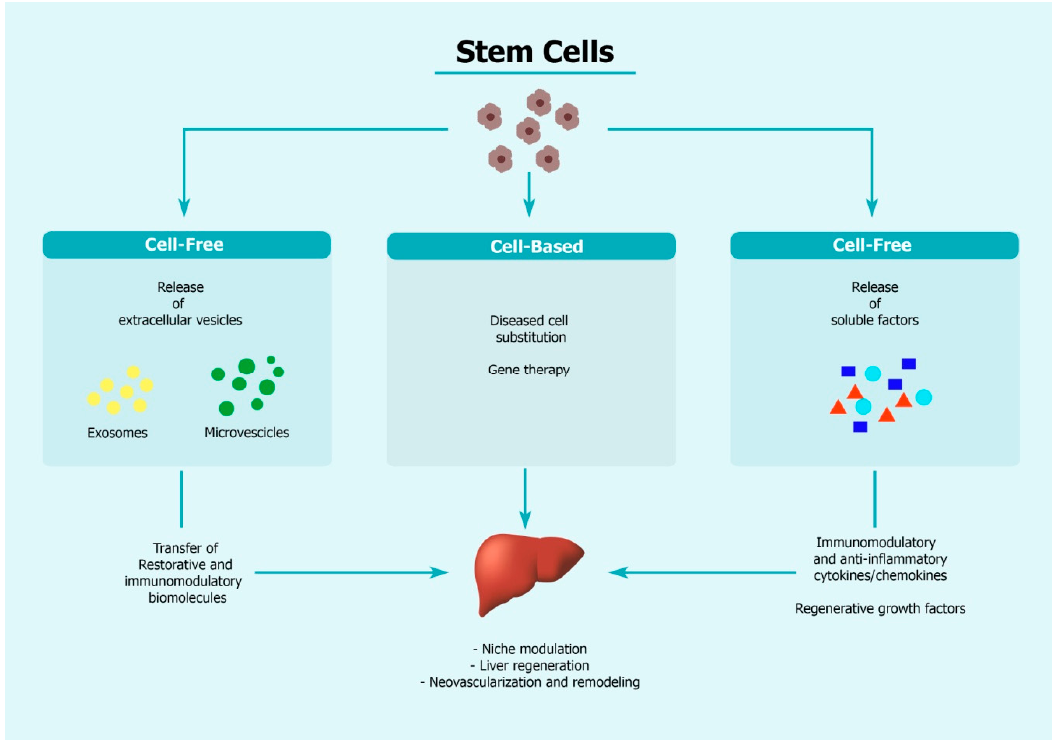
Figure 2. The mechanism of action of stem cells in the treatment of liver diseases. Stem cell injection may act in several ways in supporting liver repair. Functional stem cells may substitute diseased liver cells and at the same time provide the wild-type gene in case of genetic deficiencies, hence serving as a platform for gene therapy. Stem cells also release soluble factors such as growth factors and cytokines/chemokines to dampen liver injury. Extracellular vesicles (EVs) harbouring biomolecules with restorative properties are also produced by stem cells and participate in liver regenerative process.